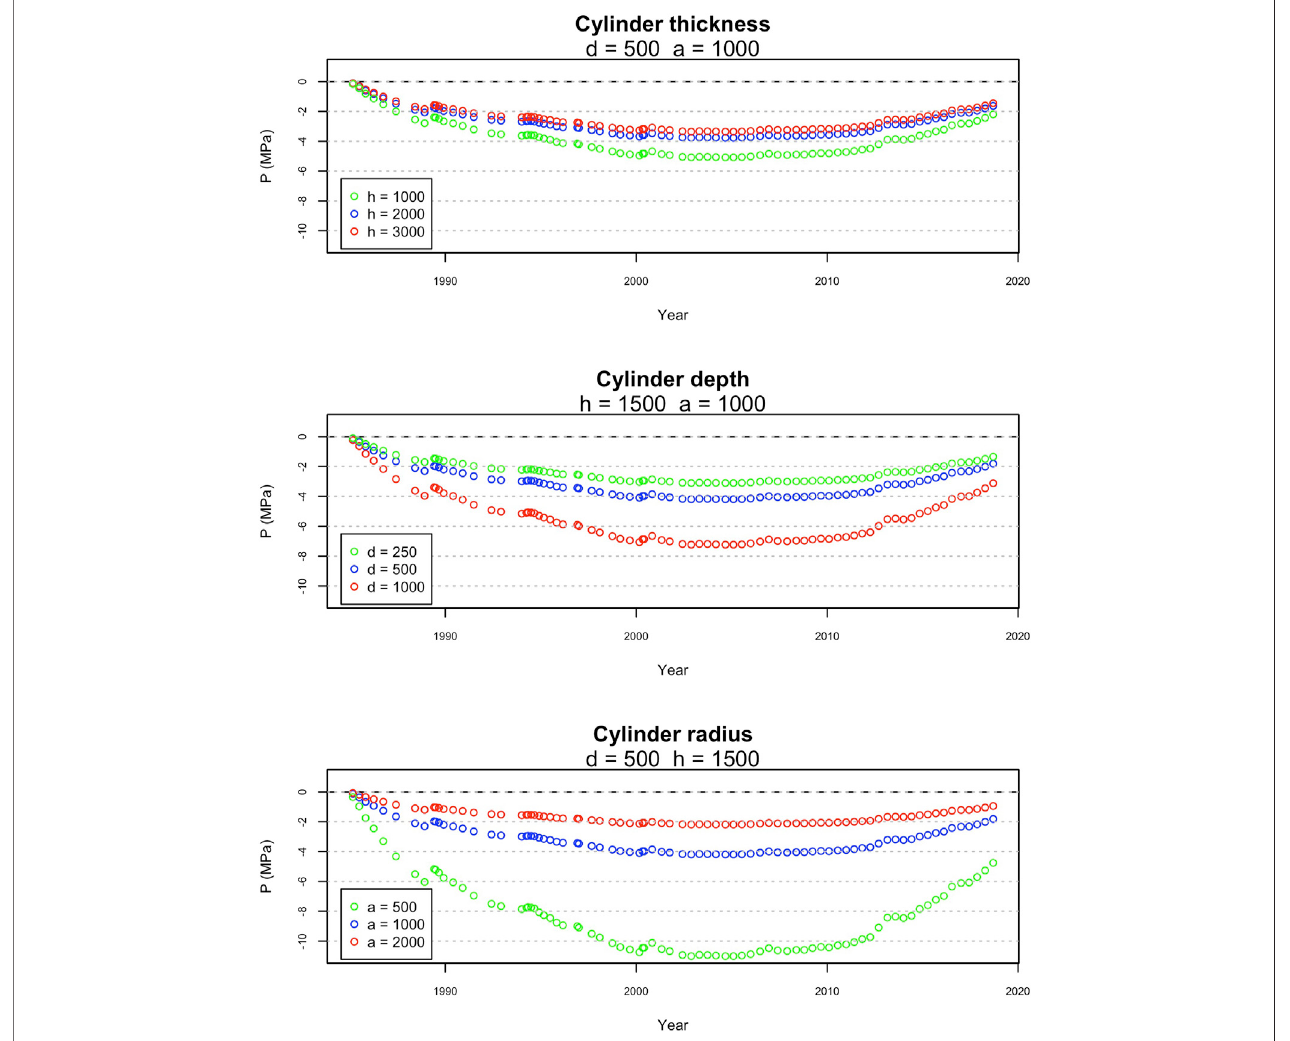
FIGURE 6 | Effects of hydrothermal reservoir geometry on pressure changes. Plots compare pressure evolution considering different reservoir thicknesses (A) , depths (B) , and radiuses (C) .